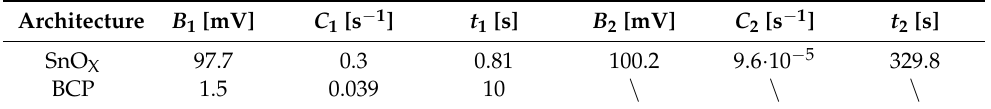
Table 3. Open-circuit voltage fitting Table 3. Open ‐ circuit voltage fitting parameters.